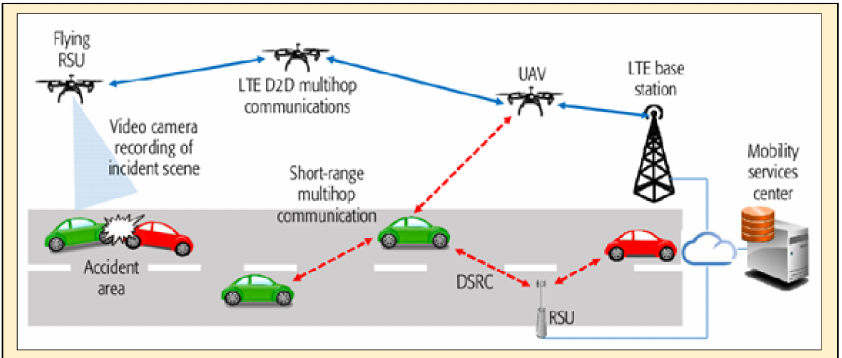
Figure 4. Illustration of UAV/vehicle interactions. Reprinted/adapted with permission from Ref. [28]. 2017, Menouar,